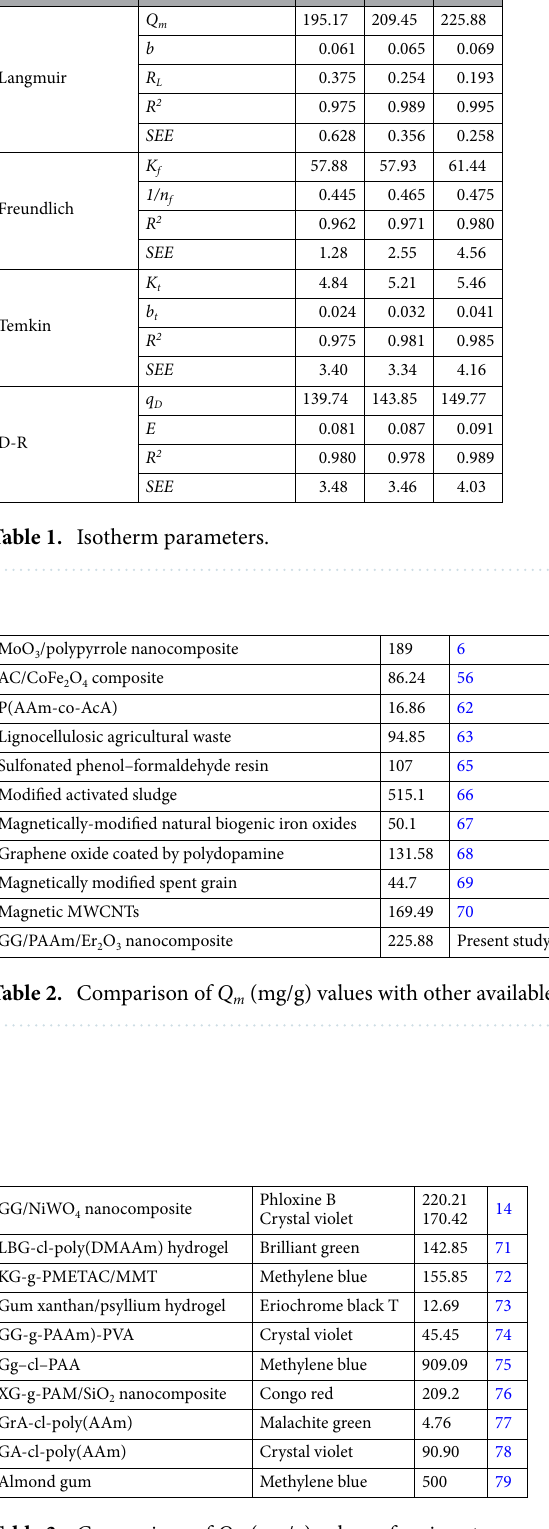
Table 3. Comparison of Q m (mg/g) values of various tree gum-based nanocomposites and their efficiency towards various